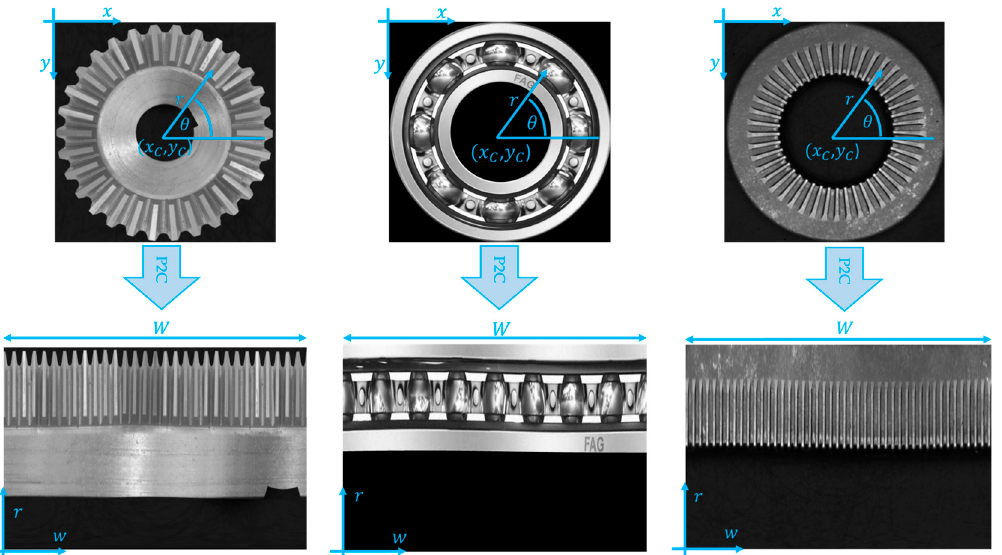
Figure 3. Polar to Cartesian coordinate transformation. The original figures in the Cartesian reference system ( x , y ) are shown on the upper row. Their correspondent images in the ( r , w ) polar coordinate system are shown on the second row. The transformation is applied on a conical gear, a ball bearing and a washer.